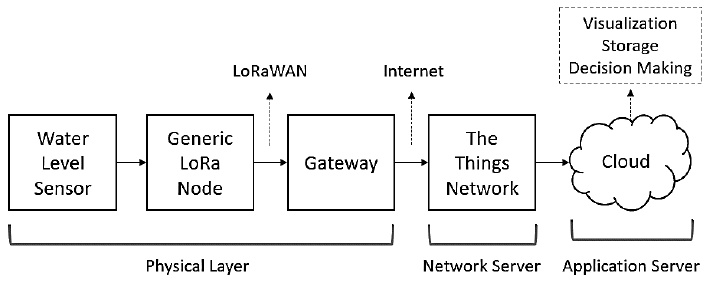
Figure 2. Block diagram of the proposed system.